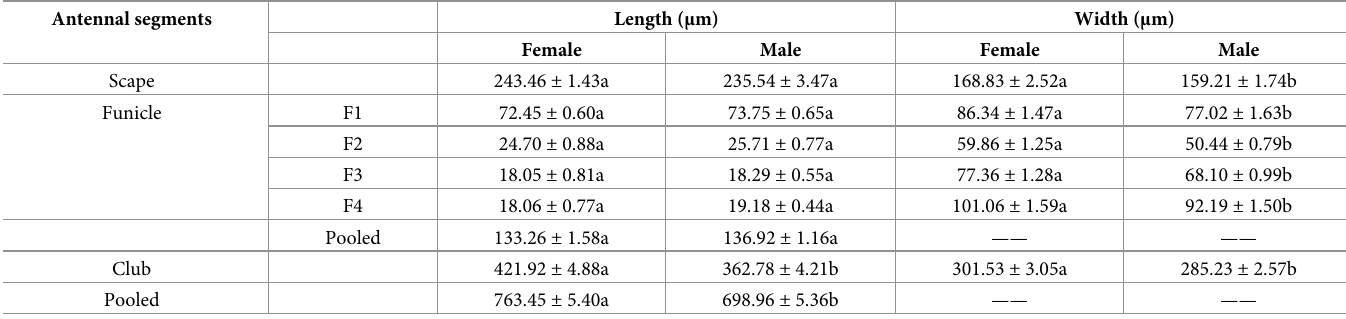
Date are presented as mean ± SE. Means in the same row followed by same letter are not significantly different ( P >